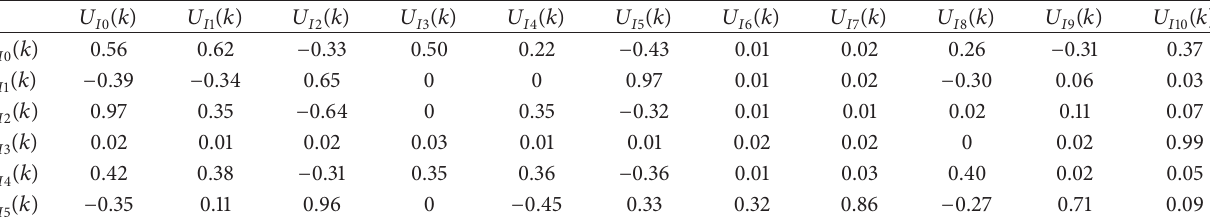
of the sensitivity of conscious YM